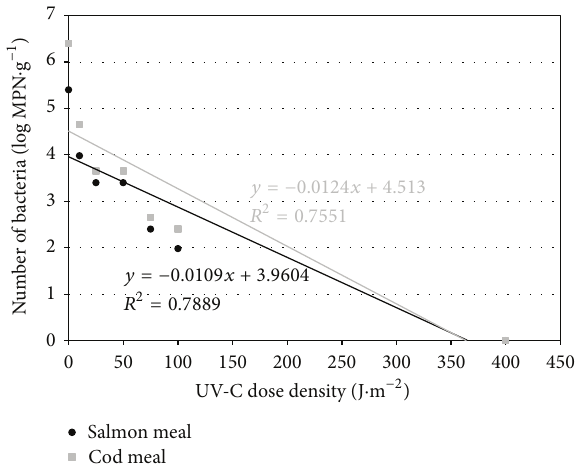
Figure 3: Regression lines describing inactivation kinetics of Ente- rococcus spp.